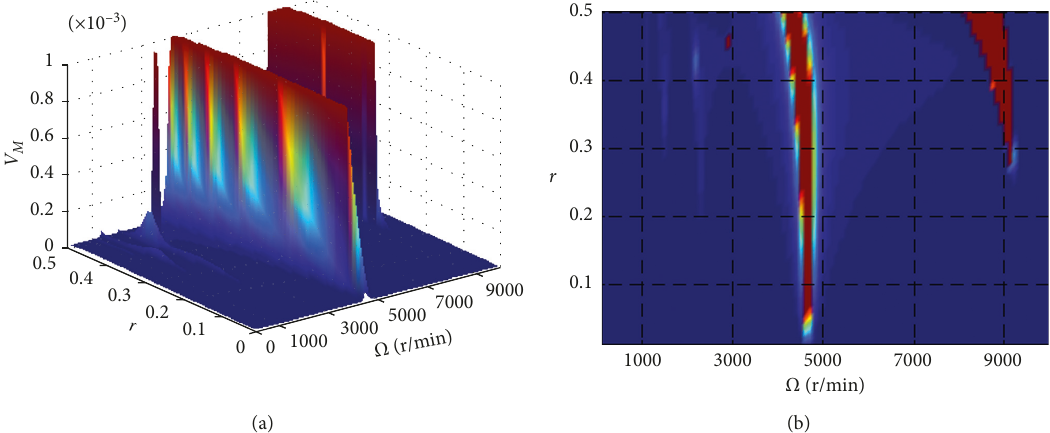
5 m, β 1 10 1/2 π , and ζ (cid:31) × (cid:31) −